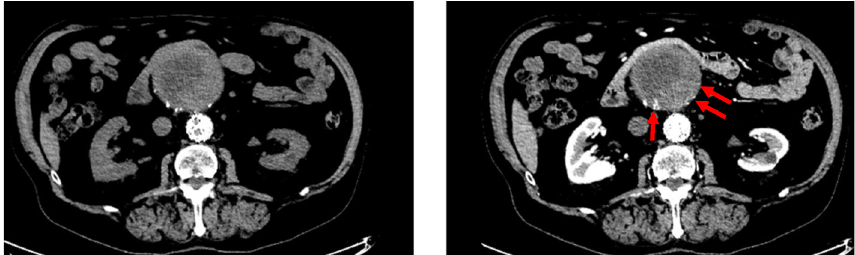
Fig. 3 Pre and post contrast CT images of Patient 1 following embolisation of small T2EL which demonstrates enhancement of peripheral sac thrombus. Tiny foci of contrast opacification along the aortic wall (arrows) may represent vasa